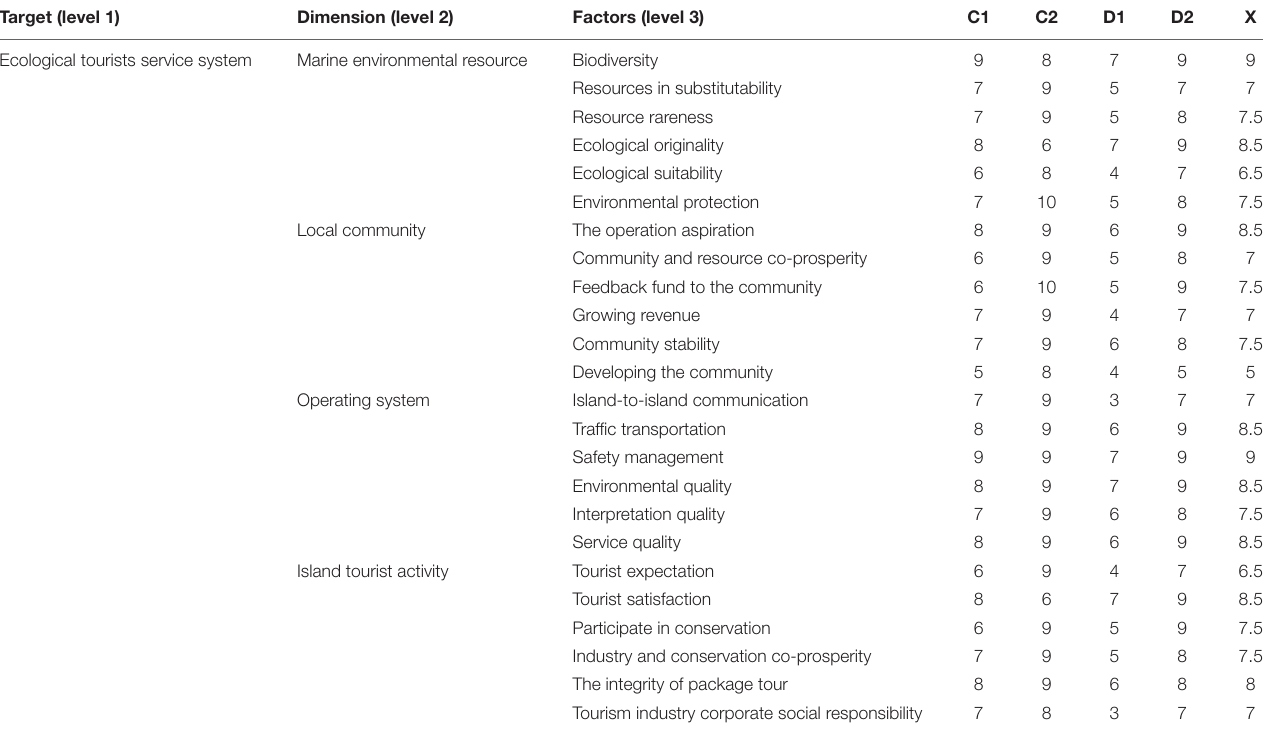
TABLE 4 | Evaluating secondary factor points from triangular fuzzy functions. Target (level 1)